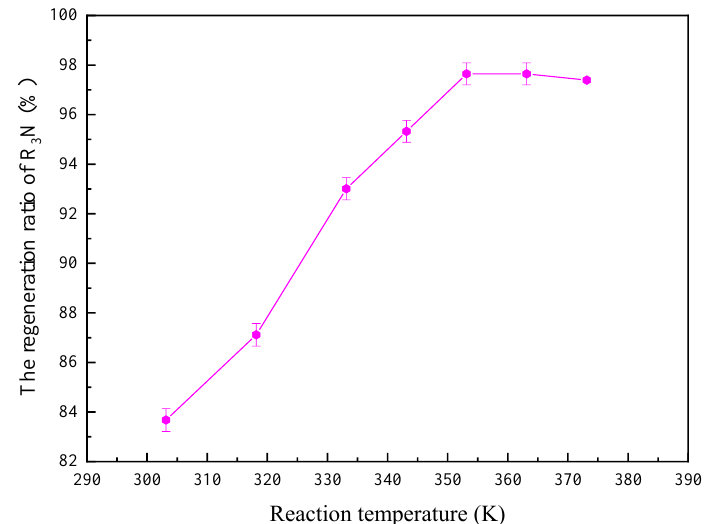
Figure 5. Effect of reaction temperature on regeneration rate of R 3 N at stirring speed = 300 rpm, reaction time = 420 s, and V a :V 0 = 0.67.